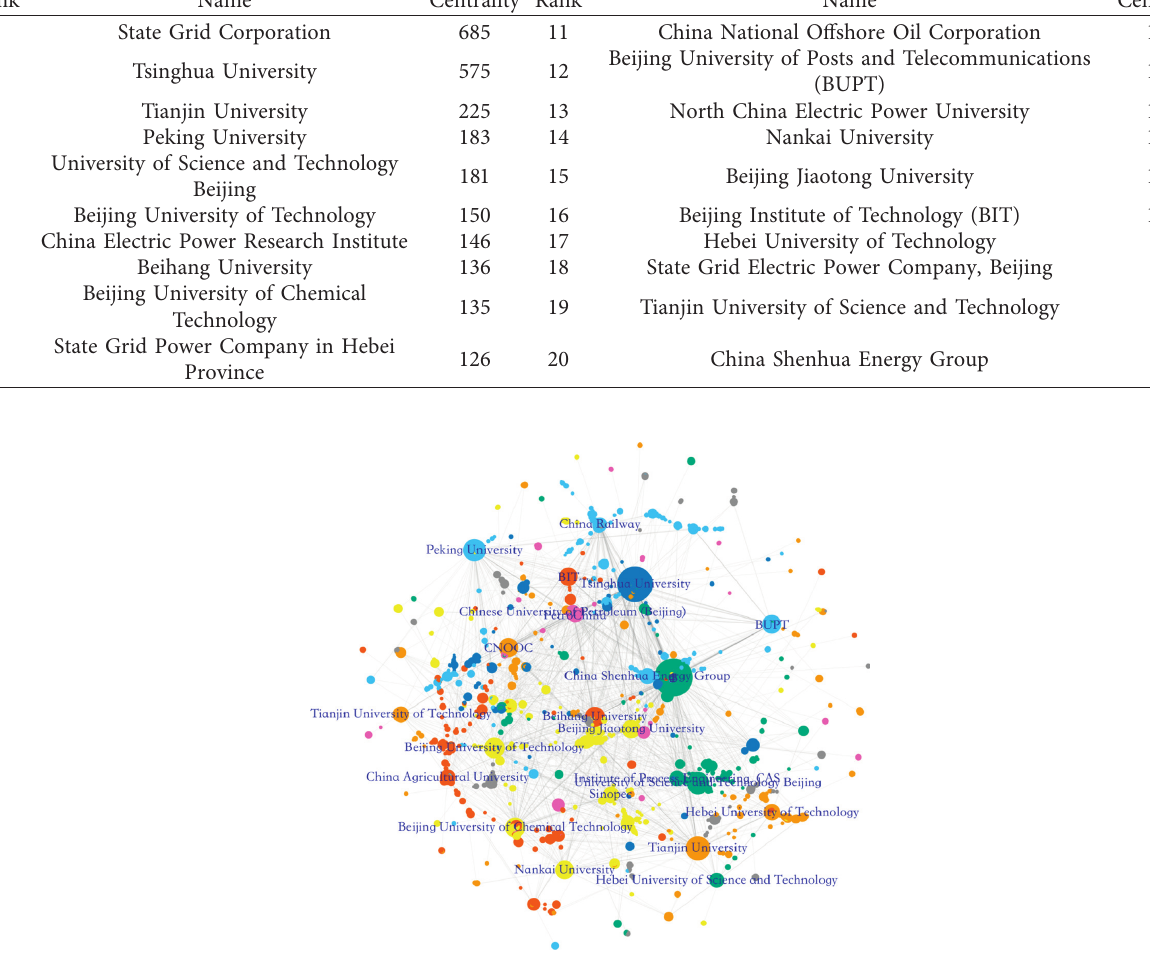
Figure 3: Visualization of the 12 communities of innovation. Note: different colors denote different communities of innovation.